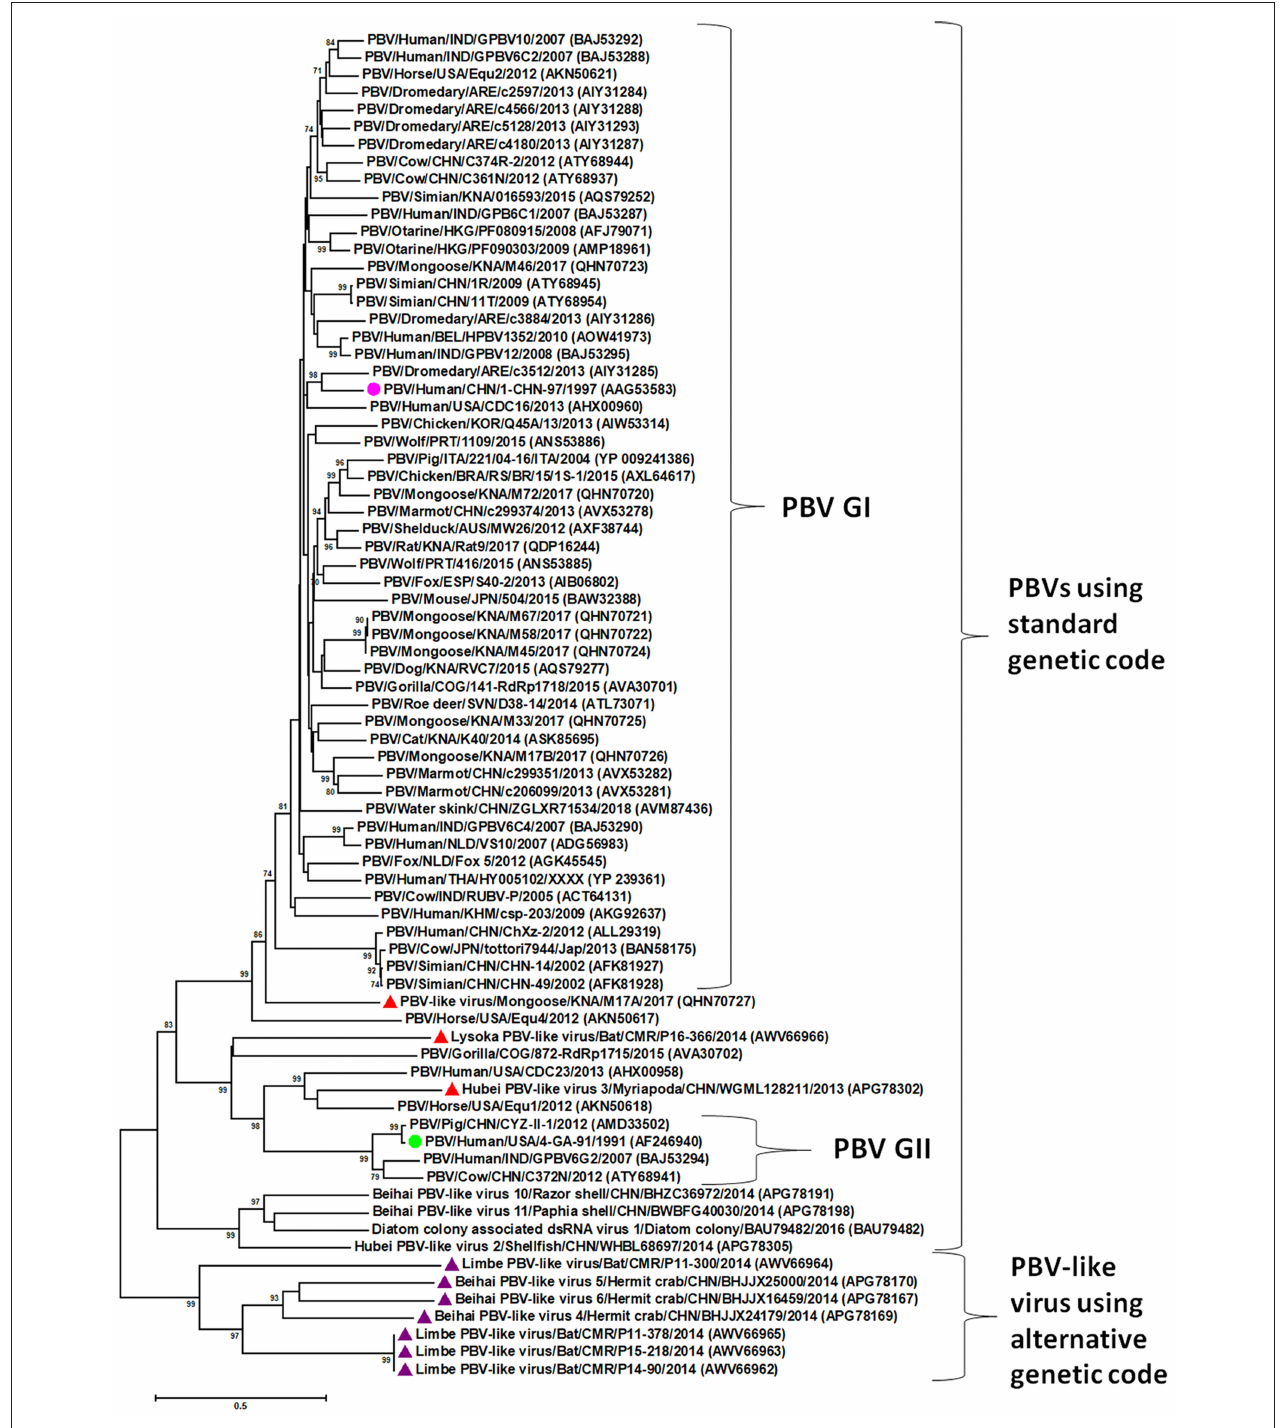
FIGURE 2 | Phylogenetic analysis of the picobirnavirus (PBV) and PBV-like RNA-dependent RNA polymerase (RdRp) sequences. The phylogenetic tree was constructed by the Maximum Likelihood method using the MEGA6 software. Phylogenetic distances were measured using the LG + G model of substitution. The tree was statistically supported by bootstrapping with 500 replicates. Bootstrap values < 70% are not shown. Scale bar, 0.5 substitutions per amino acid. The name of the PBV strain includes virus/host of detection/country/common name/date of collection. GenBank accession numbers are shown in parentheses. Pink circle: prototype PBV genogroup-I (GI) strain; green circle: prototype PBV GII strain; purple triangles: PBV-like viruses that use an alternative mitochondrial genetic code to translate the RdRp and cluster separately from PBVs using the standard genetic code; red triangles: PBV-like strains that use an alternative mitochondrial genetic code to translate the RdRp, yet cluster within PBVs using standard genetic